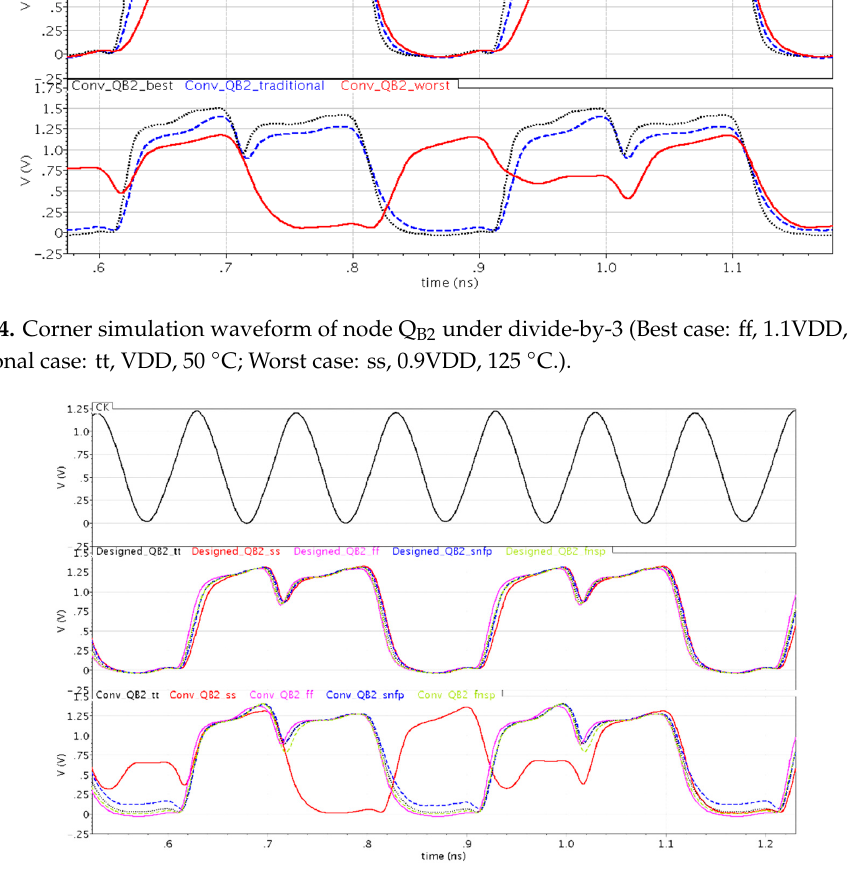
Figure 5. Corner simulation waveform of node Q B2 under divide-by-3 (Only process variation: tt, ss, ff, snfp, fnsp).